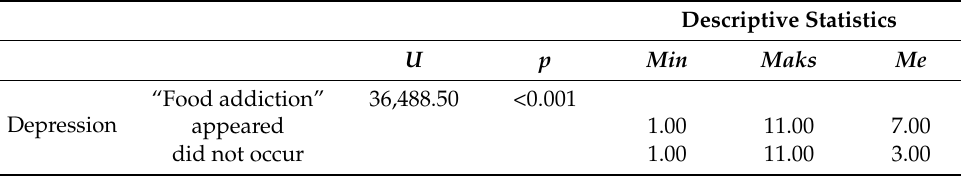
Table 6. Correlation between “food addiction” and the incidence of depression during a pandemic.